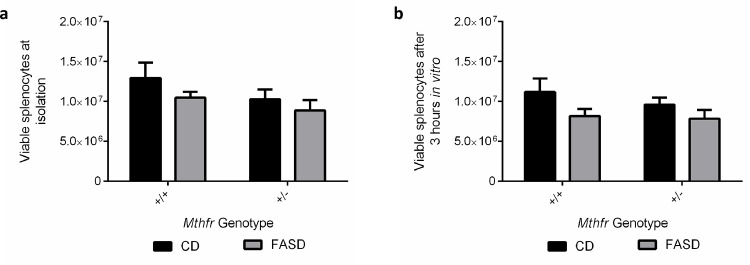
Differences in viable immune cell populations at 7 dpi between CD and FASD mice.Values are means ± SEM. Two experiments are combined for visual simplicity, but separated in the analysis using a linear mixed effects model. (a) FASD mice (grey; n = 8 (Mthfr
+/+) and n = 6 (Mthfr
+/-)) had lower numbers of viable splenocytes compared with CD mice (black; n = 8 (Mthfr
+/+) and n = 7 (Mthfr
+/+)) (p<0.05, linear mixed effects). (b) Viable splenocyte numbers were lower in FASD murine cultures after incubation with GolgiStop™ (p = 0.05, linear mixed effects).